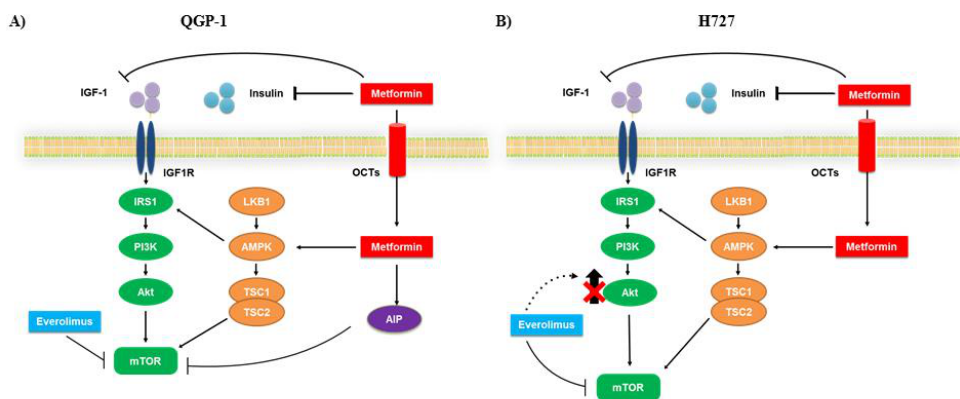
Figure 8. Schematic representation of the possible mechanism of action of metformin and everolimus in QGP-1 and H727 cells. Metformin acts via 5 (cid:48) -AMP-activated protein kinase (AMPK) dependent or independent pathways, leading to mTORC1 complex inhibition. Everolimus inhibits mTOR phosphorylation, but its long-term use is limited by the development of resistance, probably due to the activation of Akt signaling. The combination of metformin and everolimus induces a more potent blockadeofmTORandpotentiallycounteractstheresistancemechanismstriggeredbyeverolimus. ( A )In QGP-1 cells metformin did not a ff ect Akt phosphorylation, probably acting through the AIP pathway to decrease mTOR phosphorylation. ( B ) In H727 cells, metformin decreases Akt phosphorylation to suppress mTOR